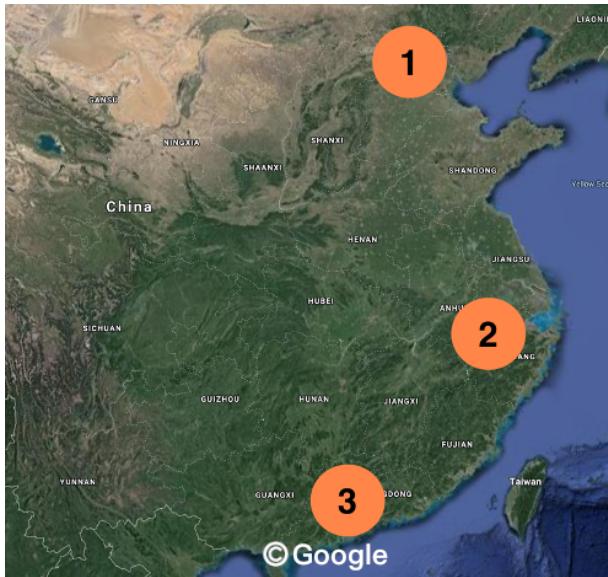
Figure 3. Clusters of AERONET sites that are used in this study to generate the regional aerosol model. Cluster 1